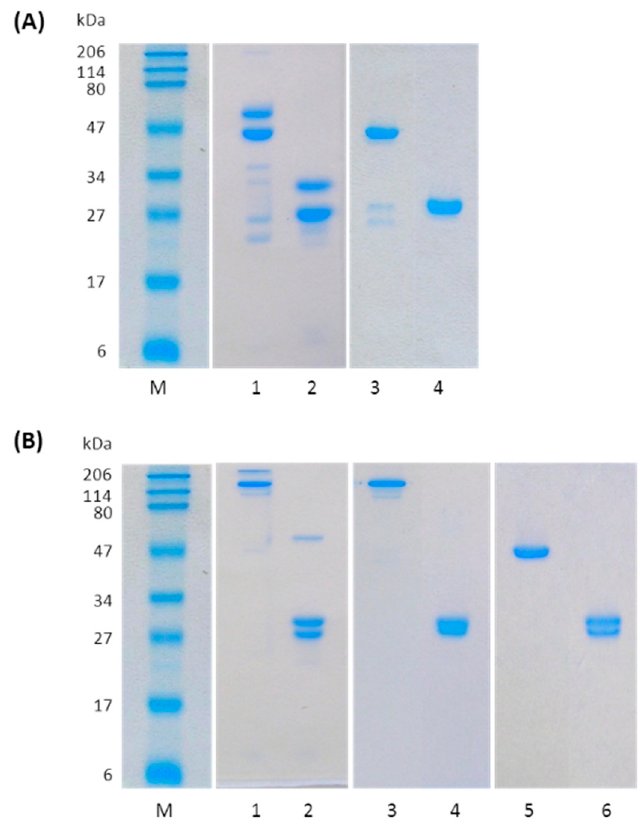
Figure 2. SDS-PAGE analysis (15% separating gel) of Fab fragments obtained by proteolytic digestion of Trastuzumab with papain or pepsin: ( A ) Proteolysis of Trastuzumab with papain: protein standards (line M); reaction mixture after 90 min incubation at 37 °C under non reducing (lane 1) and reducing conditions (lane 2); and purified Trast Fab under non reducing (lane 3) and reducing conditions (lane 4); ( B ) Proteolysis of trastuzumab with pepsin: protein standards (line M); reaction mixture after 16 h incubation at 37 °C under non reducing (lane 1) and reducing conditions (lane 2); purified Trast F(ab’) 2 under non reducing (lane 3) and reducing conditions (lane 4); and purified Trast Fab’ under non reducing (lane 5) and reducing conditions (lane 6). Proteins were visualized by Bio-Safe Coomassie blue stain. Reduction was achieved by treating samples with 2-mercaptoethanol before loading.2.2. N-terminal Trast Fab PEGylation